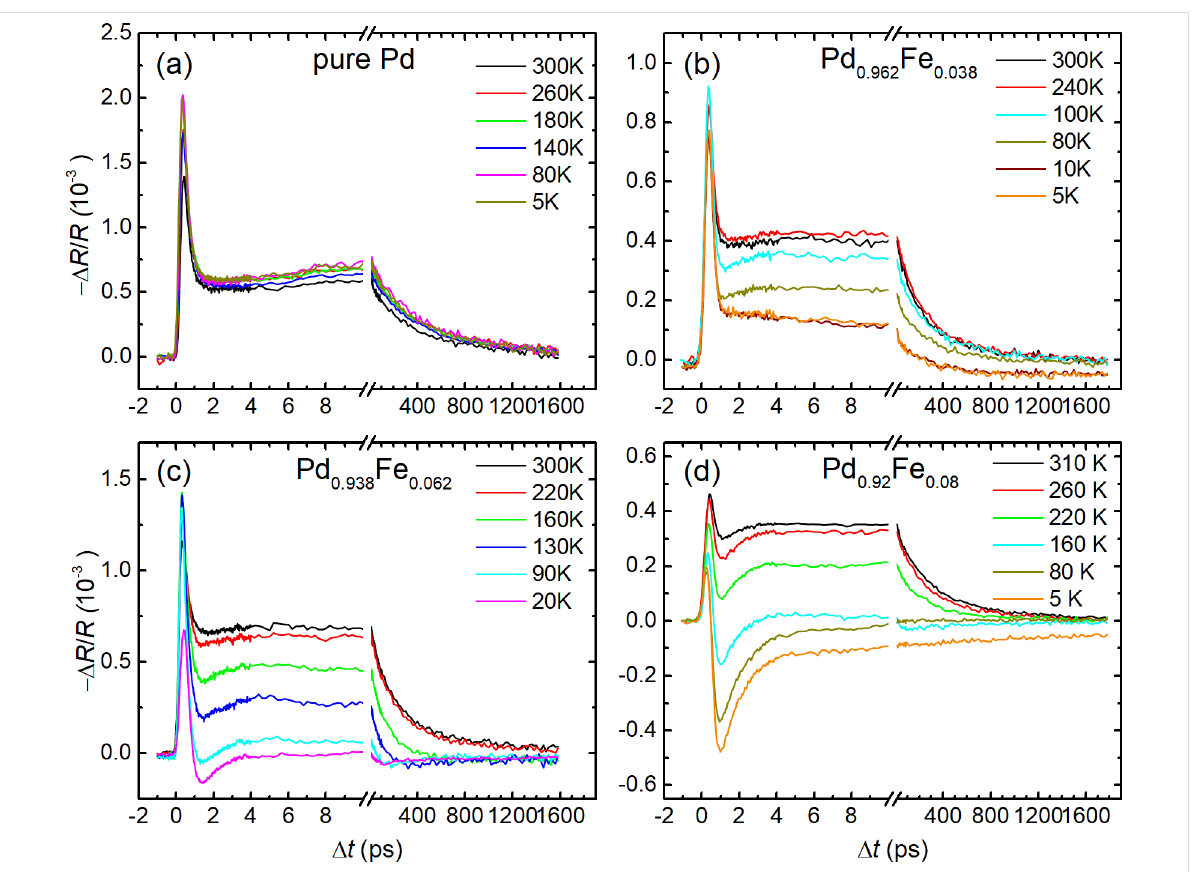
Figure 1: Temperature evolutions of the reflectivity transients of Pd 1 − x Fe x alloy thin epitaxial films for compositions with x = 0 (a), 0.038 (b), 0.062 (c), and 0.080